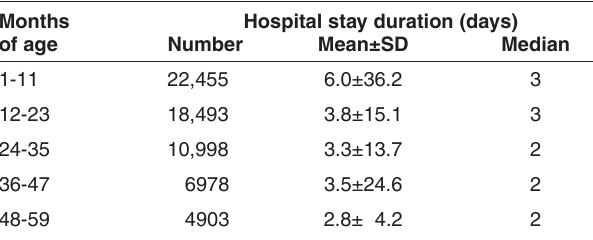
TABLE 4 Hospital stay duration, by age group, for diarrhea- related hospitalizations (all diagnoses) among children younger than five years of age in Quebec, April 1, 1985 to March 31,